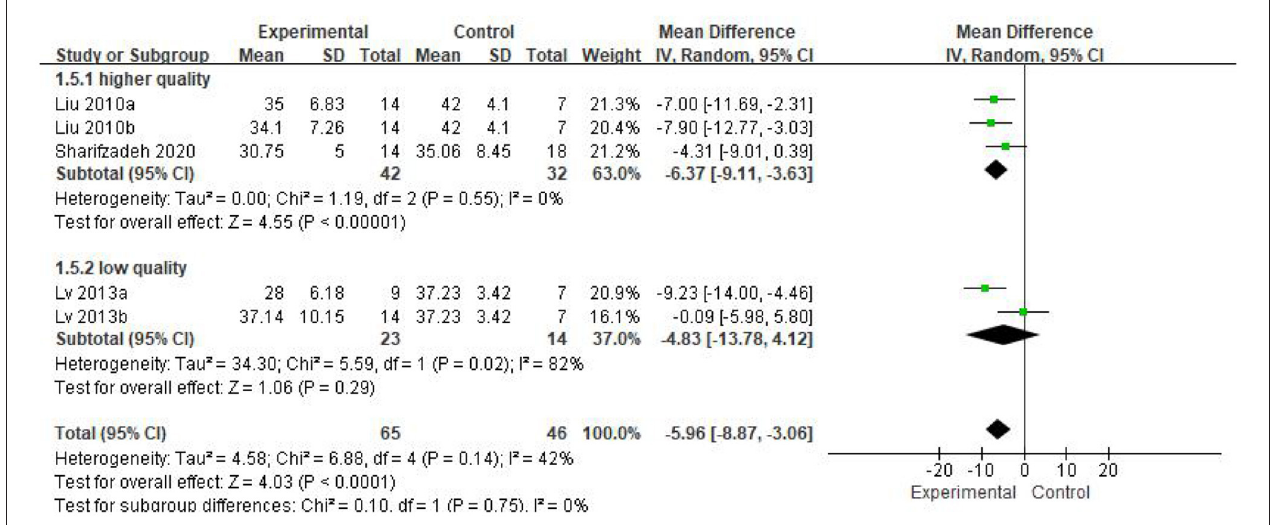
FIGURE 7 | CARS Forest plot of subgroup